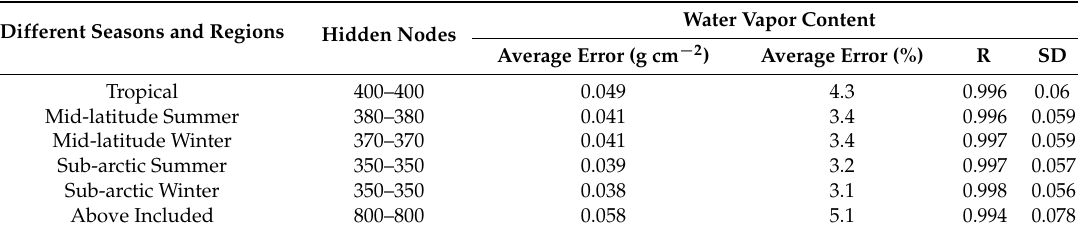
Table 1. Summary of retrieval